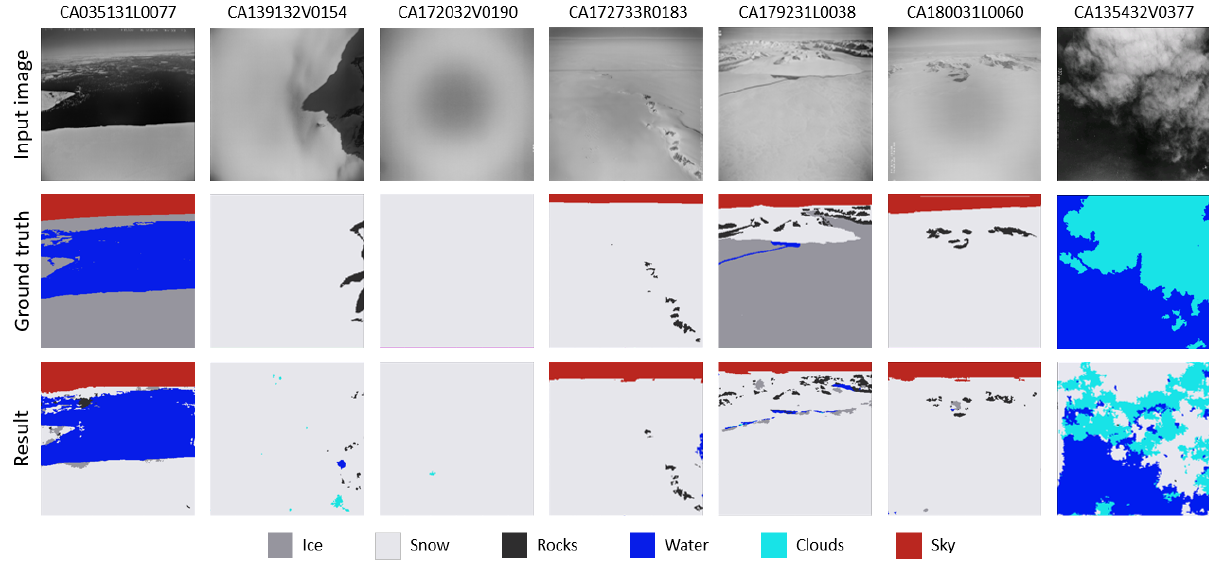
Figure 6. Result with input image (top), ground truth (middle) and prediction after post-processing (bottom)